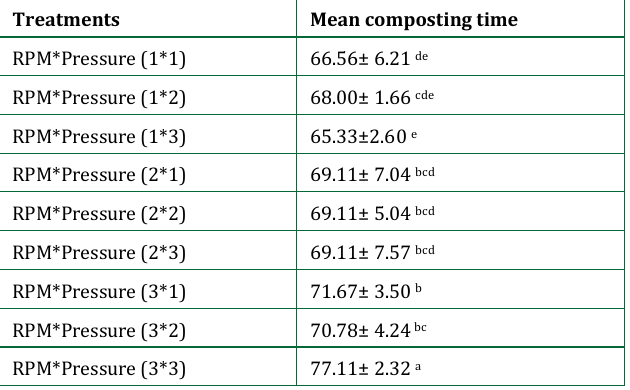
Table 4: Combine effect of RPM * Pressure on composting time